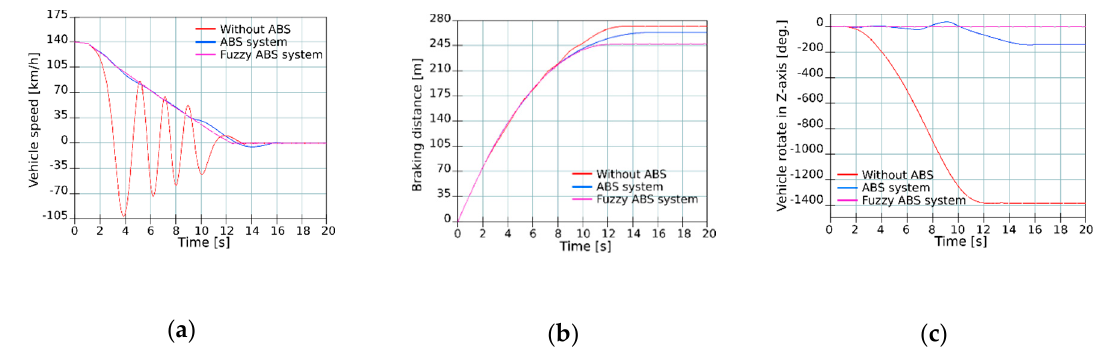
Figure 13. Test on road with combined adhesion at speed 140 km / h—( a ) Speed curve; ( b ) Braking distance; ( c ) Vehicle rotation. Table 6. Test results on road with combined adhesion at speed 140 km / h.